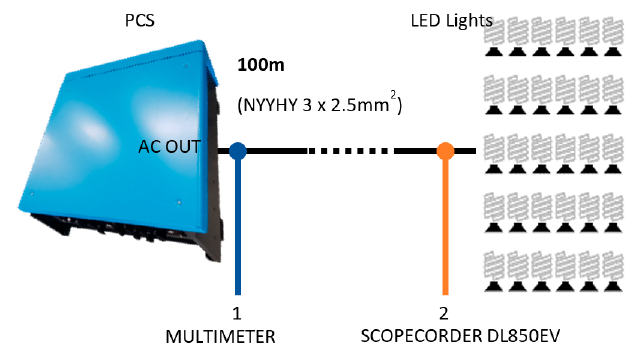
Figure 7. PCS field evaluation with distant loads.